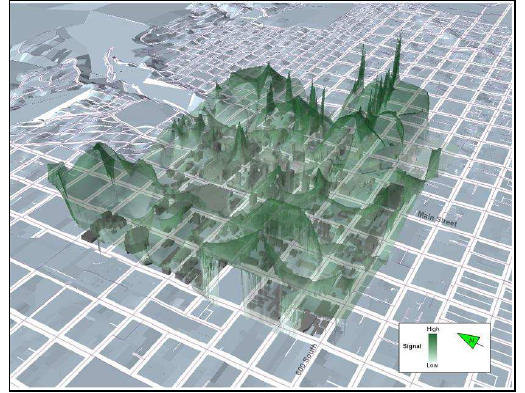
Fig.5; The invisible geography of wireless "wi-fi" Internet signal, Salt Lake City, UT. The same representation can be used to highlight financial infrastructures; the banks can be represented as visible nodes in the network, while the transactions and the transfer of money are invisible and can be represented as virtual lines of the network. In fig. 6 the representation of an invisible financial indicator such the “market value” in New York.